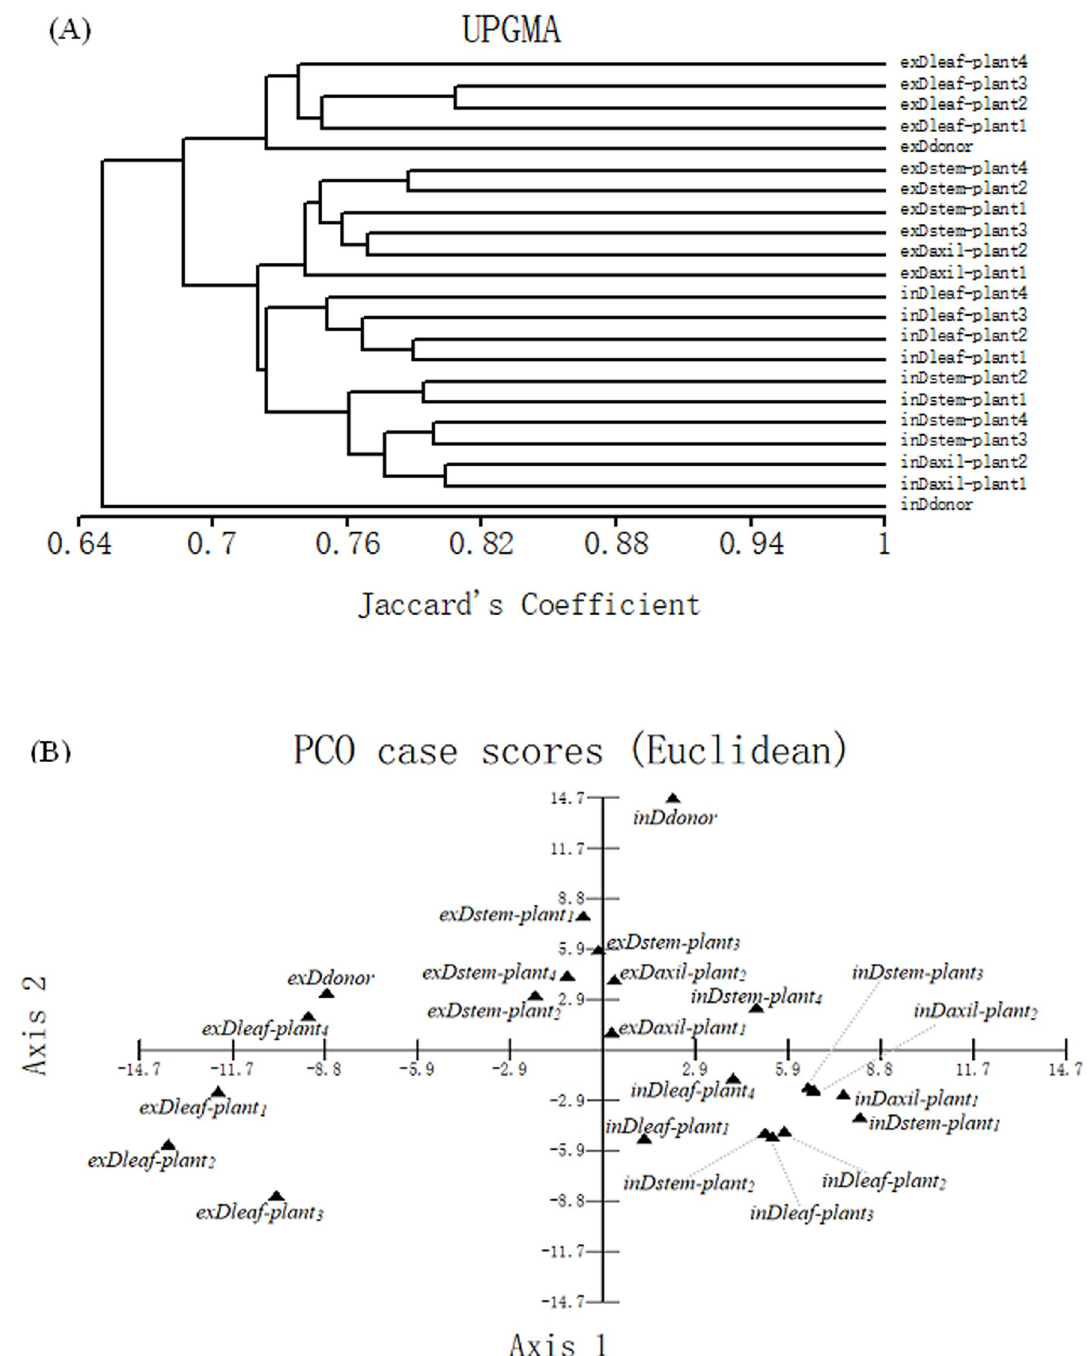
Fig 4. Dendrogram illustrating coefficient similarities among samples in L . ruthenicum D group by the UPGMA cluster analysis based on the MSAP profiles (A), and associations among the samples in D group revealed by PCA (B).